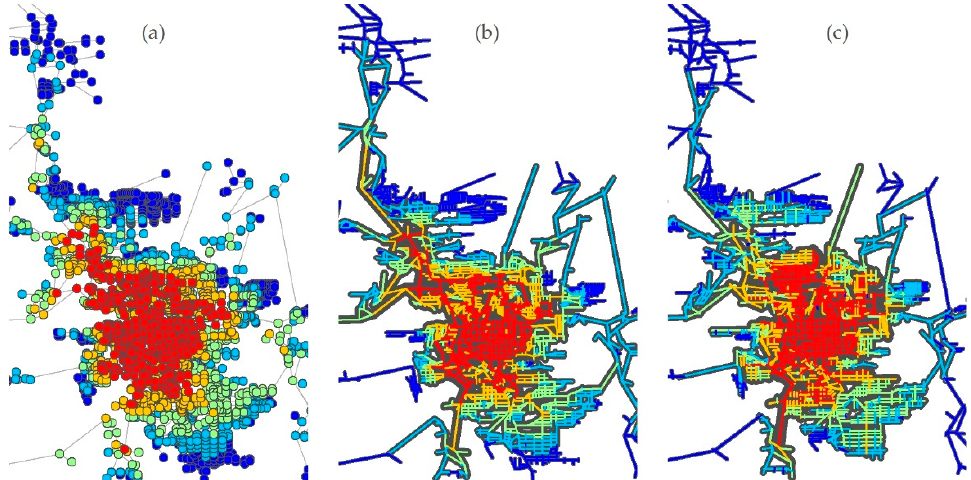
Figure 7. Closeness Centrality in three different descriptive system: ( a ) Intersections; ( b ) Street Segments; ( c ) Axial Lines. Source: Authors, July 2018.